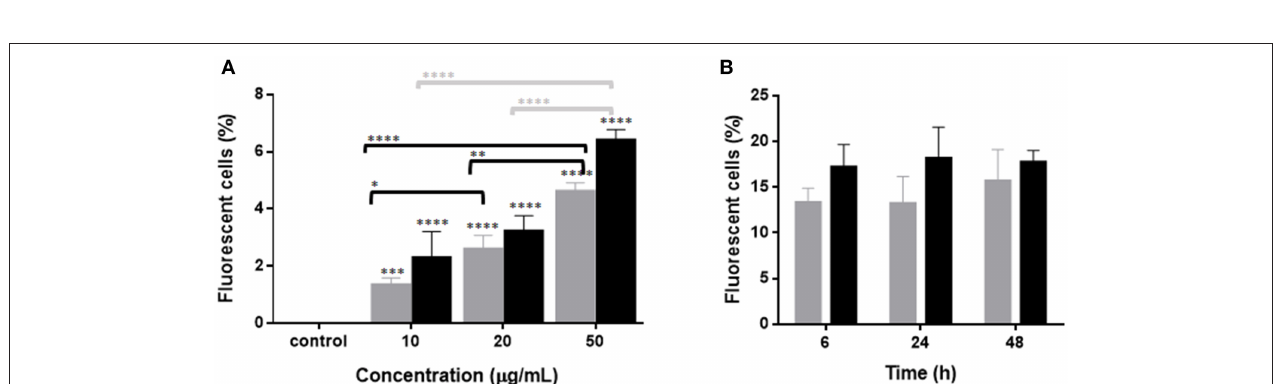
FIGURE 1 | Uptake of IB TNF α and IB frg16G − VHSV by RBCs in vitro. (A) Dose-response of RBCs incubated 24h with 10–50 µ g/mL IB frg16G − VHSV (gray bars) or IB TNF α (black bars). (B) Time course monitoring of RBCs incubated 6, 24, and 48h with 160 µ g/mL IB frg16G − VHSV (gray bars) or 80 µ g/mL IB TNF α (black bars). Data represent mean ± SD ( n = 4). Two-way Anova and Dunnett’s multiple comparisons test was performed between all conditions and control (untreated cells) and among concentrations. *, **, ***, **** P -value < 0.05, 0.01, 0.001, and 0.0001,